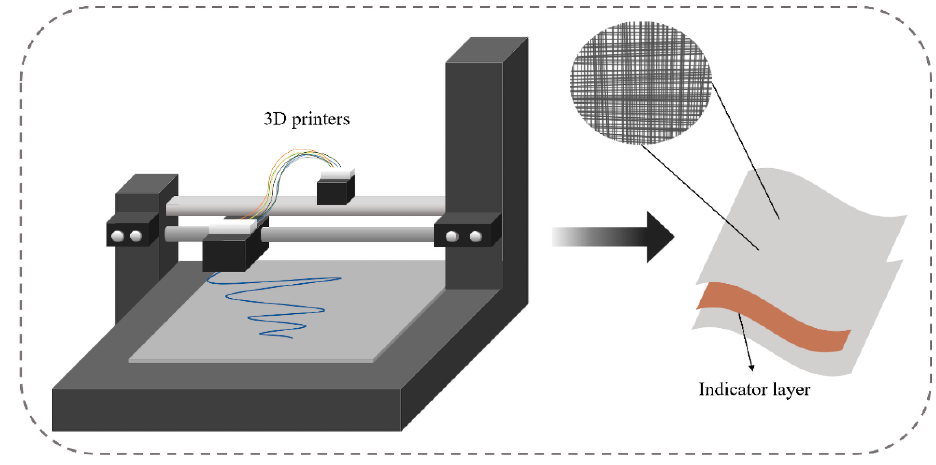
Figure 3. Diagram of a 3D printer.